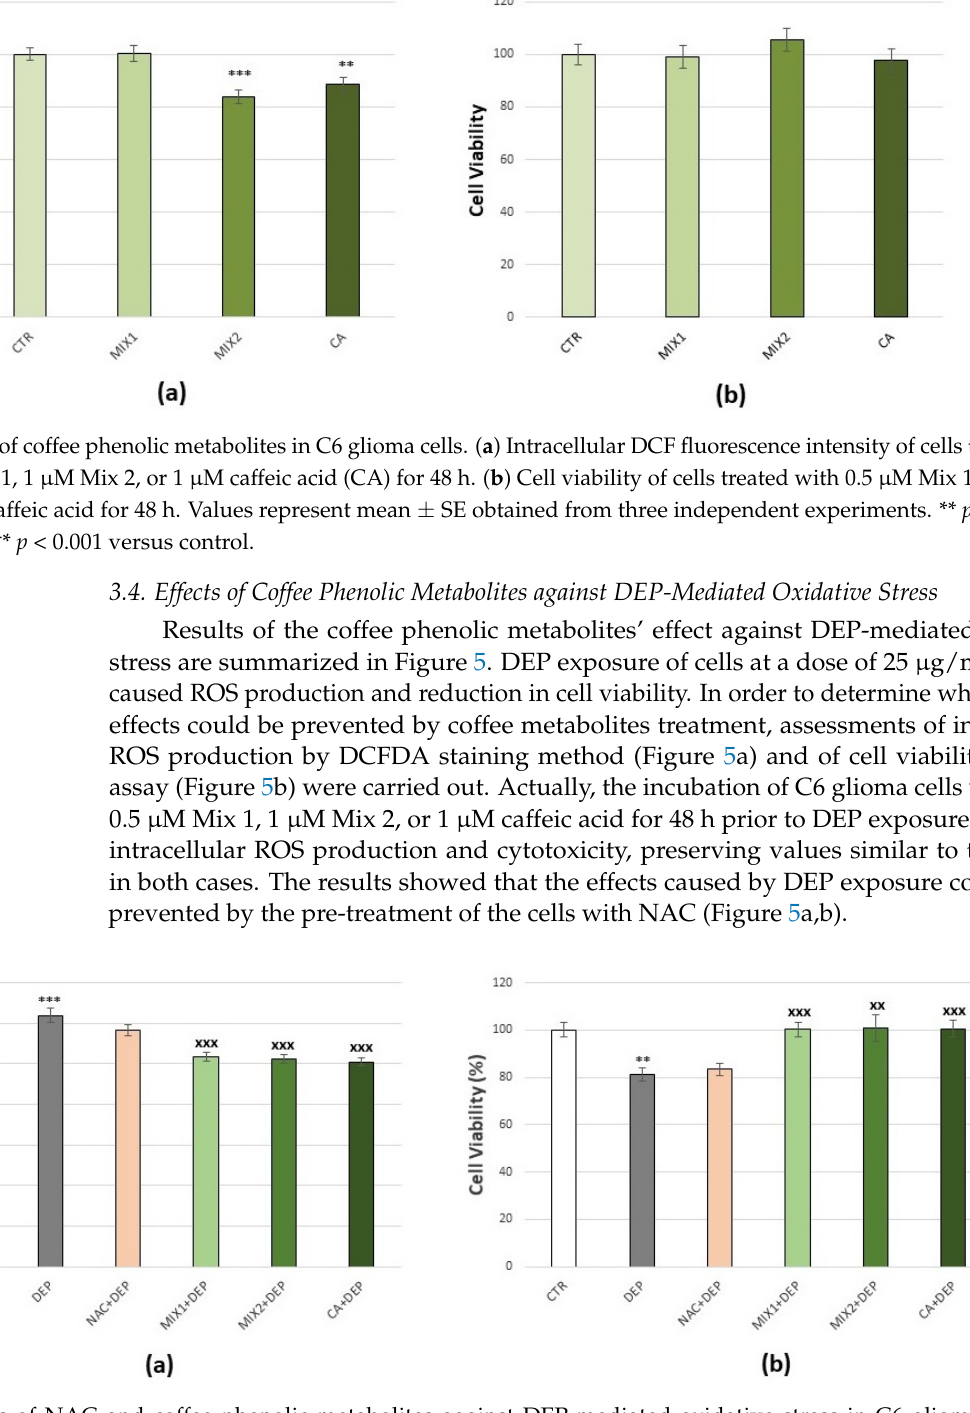
Figure 5. Effects of NAC and coffee phenolic metabolites against DEP-mediated oxidative stress in C6 glioma cells. ( a ) Intracellular DCF fluorescence intensity of cells treated with 25 µ g/mL DEPs for 12 h with and without pre-treatment with 5 mM NAC for 24 h or 0.5 µ M Mix 1, 1 µ M Mix 2, and 1 µ M caffeic acid (CA) for 48 h. ( b ) Cell viability of cells treated with 25 µ g/mL DEPs for 12 h with and without pre-treatment with 5 mM NAC for 24 h or 0.5 µ M Mix 1, 1 µ M Mix 2, and 1 µ M caffeic acid for 48 h. Values represent mean ± SE obtained from three independent experiments. ** p < 0.01 versus control, *** p < 0.001 versus control, XX p < 0.01 versus DEP, XXX p < 0.001 versus DEPs.